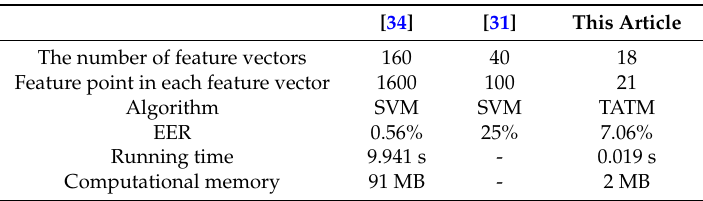
Table 6. Comparison with previous works.